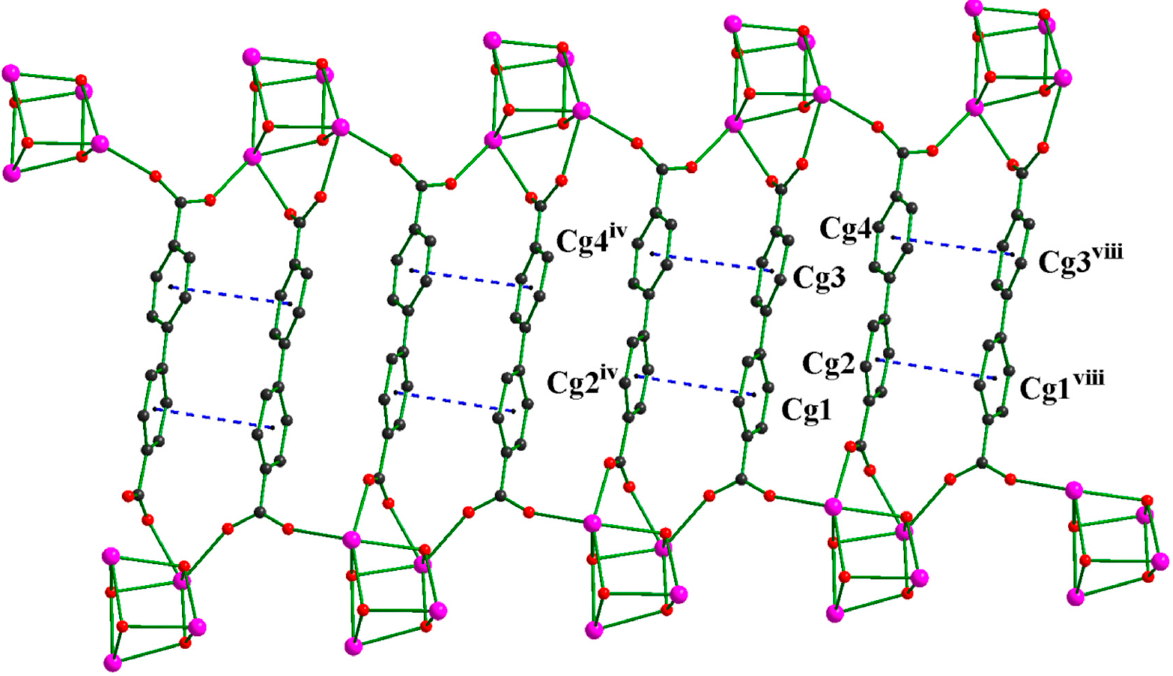
Figure 7. View of the π ⋯ π interactions in 1 (Blue dash lines represent π ⋯ π interactions, symmetry codes see in the Table S2 from Supplementary Materials).